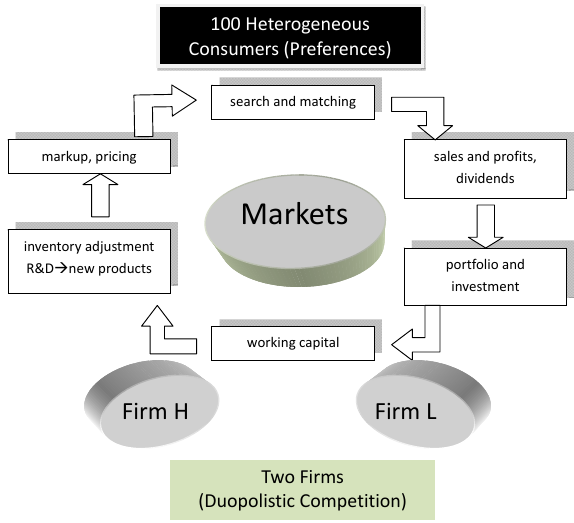
Figure 8. An overview of the market